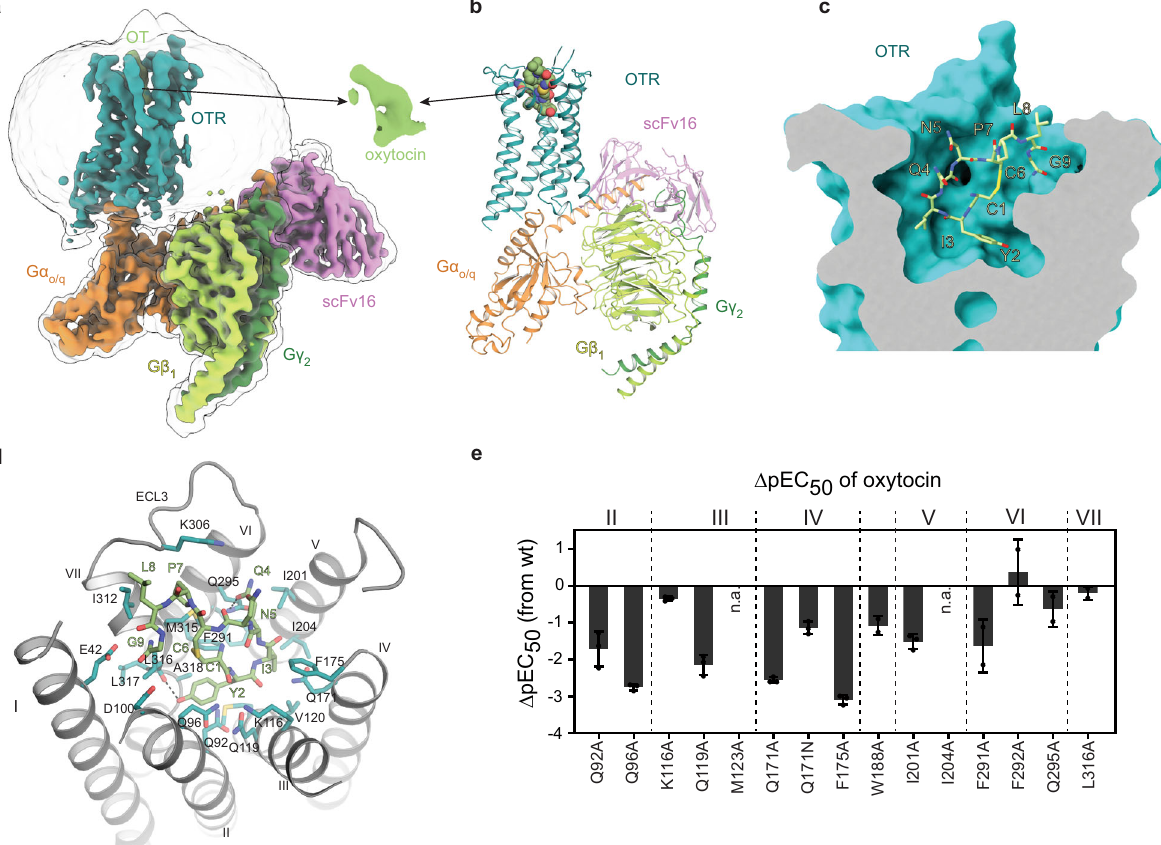
Fig. 1 Overall structure of the oxytocin bound OTR. a Cryo-EM map of the OTR:OT:G o/q :scFv16 complex. b Molecular model of the OTR:OT:G o/q :scFv16 complex. Ligand atoms are coloured according to atom types. c Clipped surface representation of the OT orthosteric binding pocket with OT shown as bright green sticks. d Detailed interactions of OT with OTR. e Agonist potency pro fi les of selected mutants. Bars represent differences in IP1 accumulation potency (mean Δ pEC 50 ± standard deviation from two (W188A, F291A, F292A, Q295A, L316A) or three (all other constructs) independent experiments in duplicates) compared to wtOTR. n.a., no activation. Data are provided in Supplementary Table 2 and as a Source Data fi